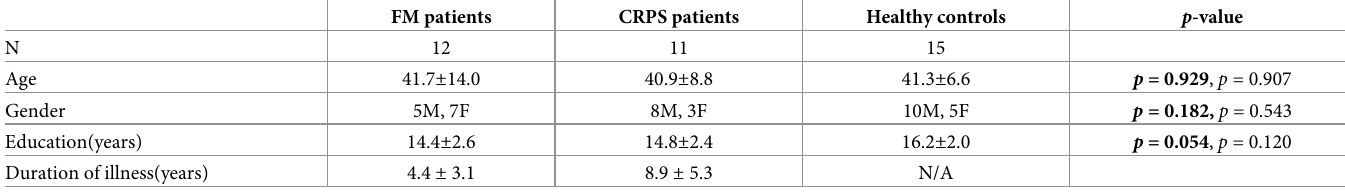
Table 1. Participant‘s demographic